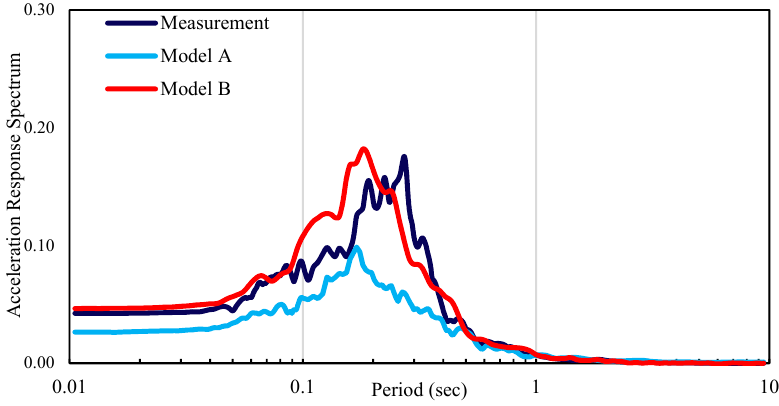
Figure 8. The sample prediction by models A and B and the measurement (FKSH18).